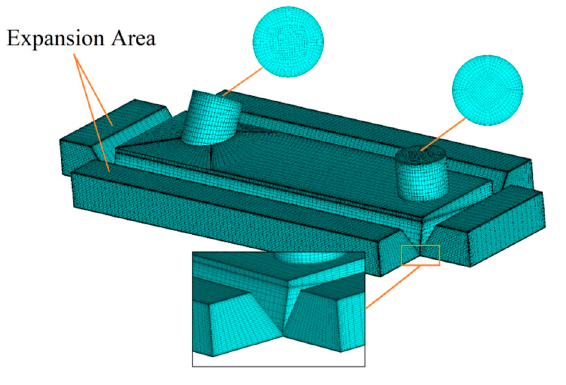
Figure 3. Computational mesh.